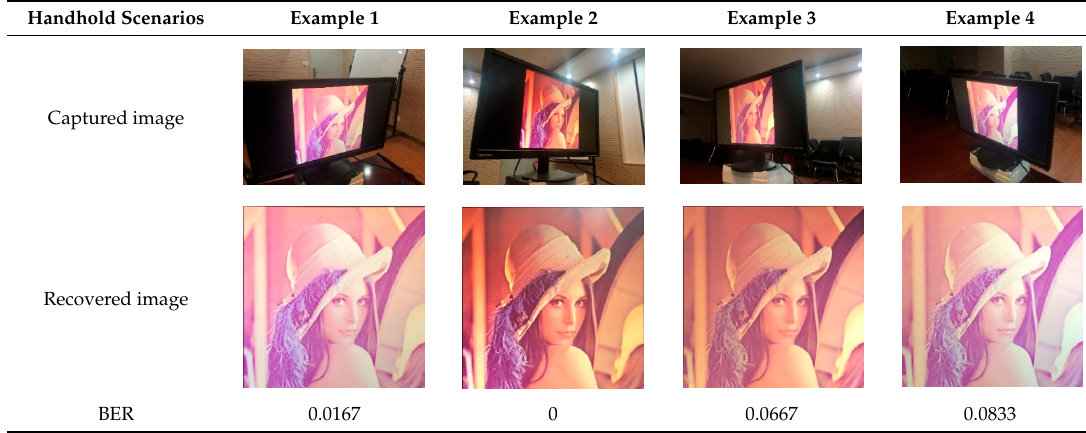
Table 5. Examples of Handhold Shooting.